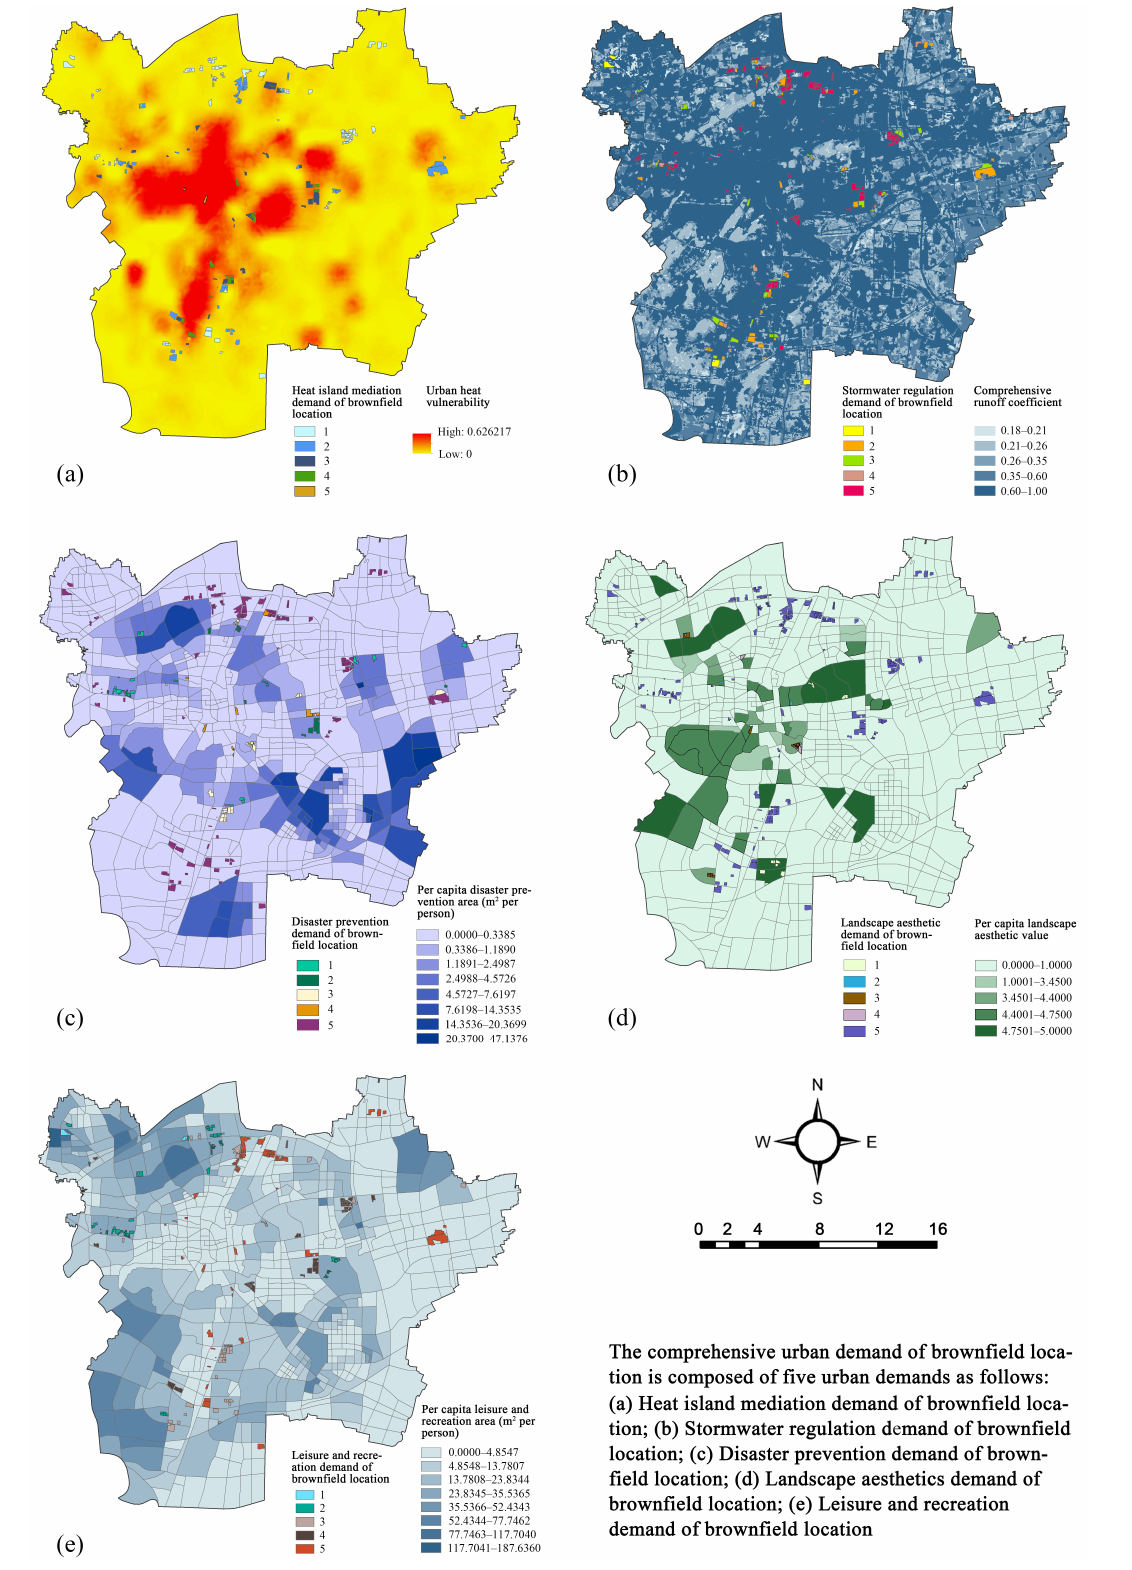
Figure 4. Values of the five categories of urban demand in the brownfield location. ( a ) Heat island mediation; ( b ) stormwater regulation; ( c ) disaster prevention; ( d ) landscape aesthetics; ( e ) leisure and